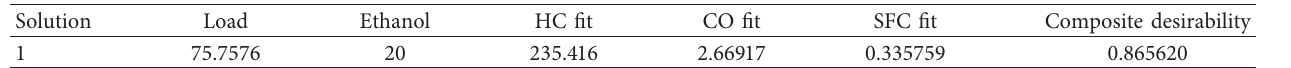
Figure 10: Response optimization plot of SFC, CO, and Table 4: Parametric optimized results.